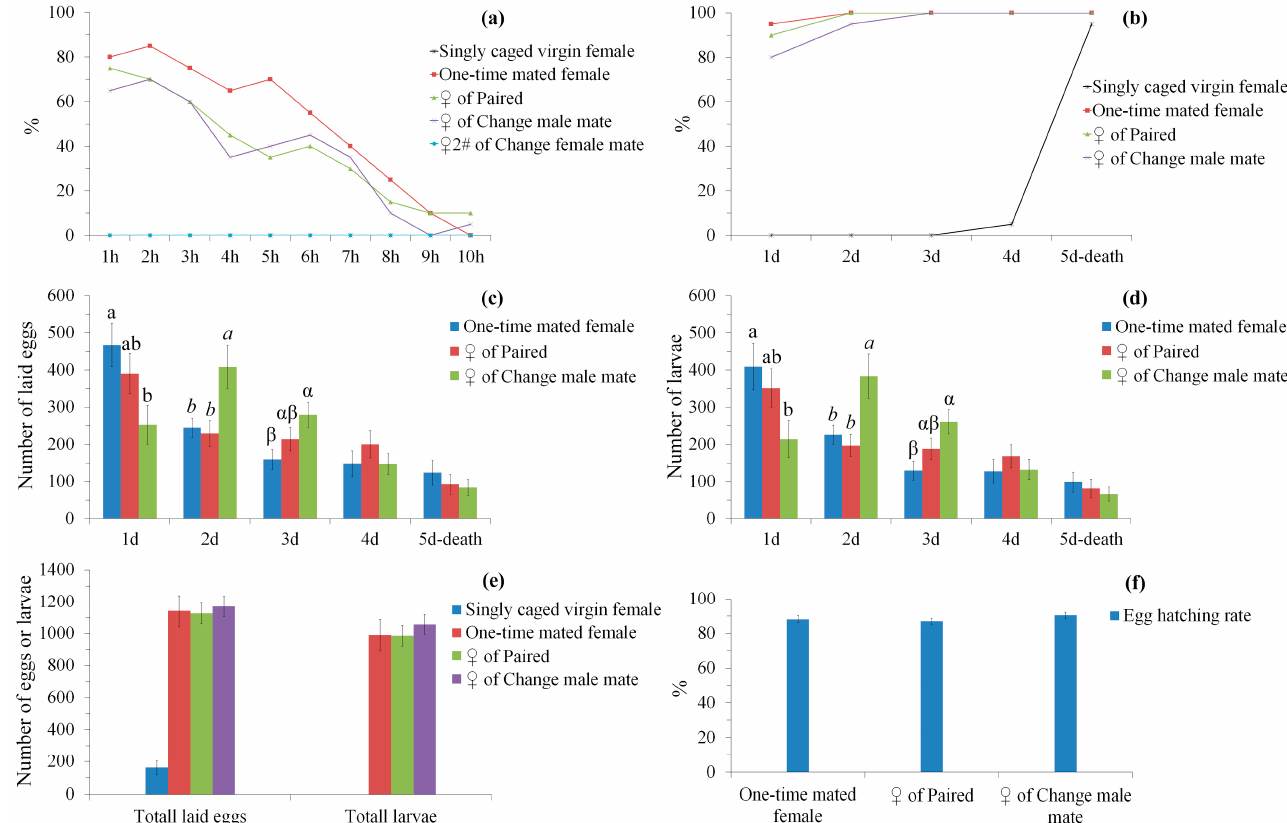
Figure 2. Oviposition pattern and fecundity under different mating conditions in S. frugiperda (20 females were used for each treatment). ( a ) hourly percentage of ovipositing females. The percentage of an hour in a treatment = the number of ovipositing females observed in this hour/the number of total females %; ( b ) accumulated percentage of females that have laid eggs; ( c ) daily fecundity (number of eggs laid) per female; ( d ) daily hatched eggs (number of larvae) per female; ( e ) lifetime total laid eggs and larvae per female; ( f ) egg hatching rate per female. In each oviposition day of subgraph ( c , d ), bars with different letters are significantly different ( p < 0.05).